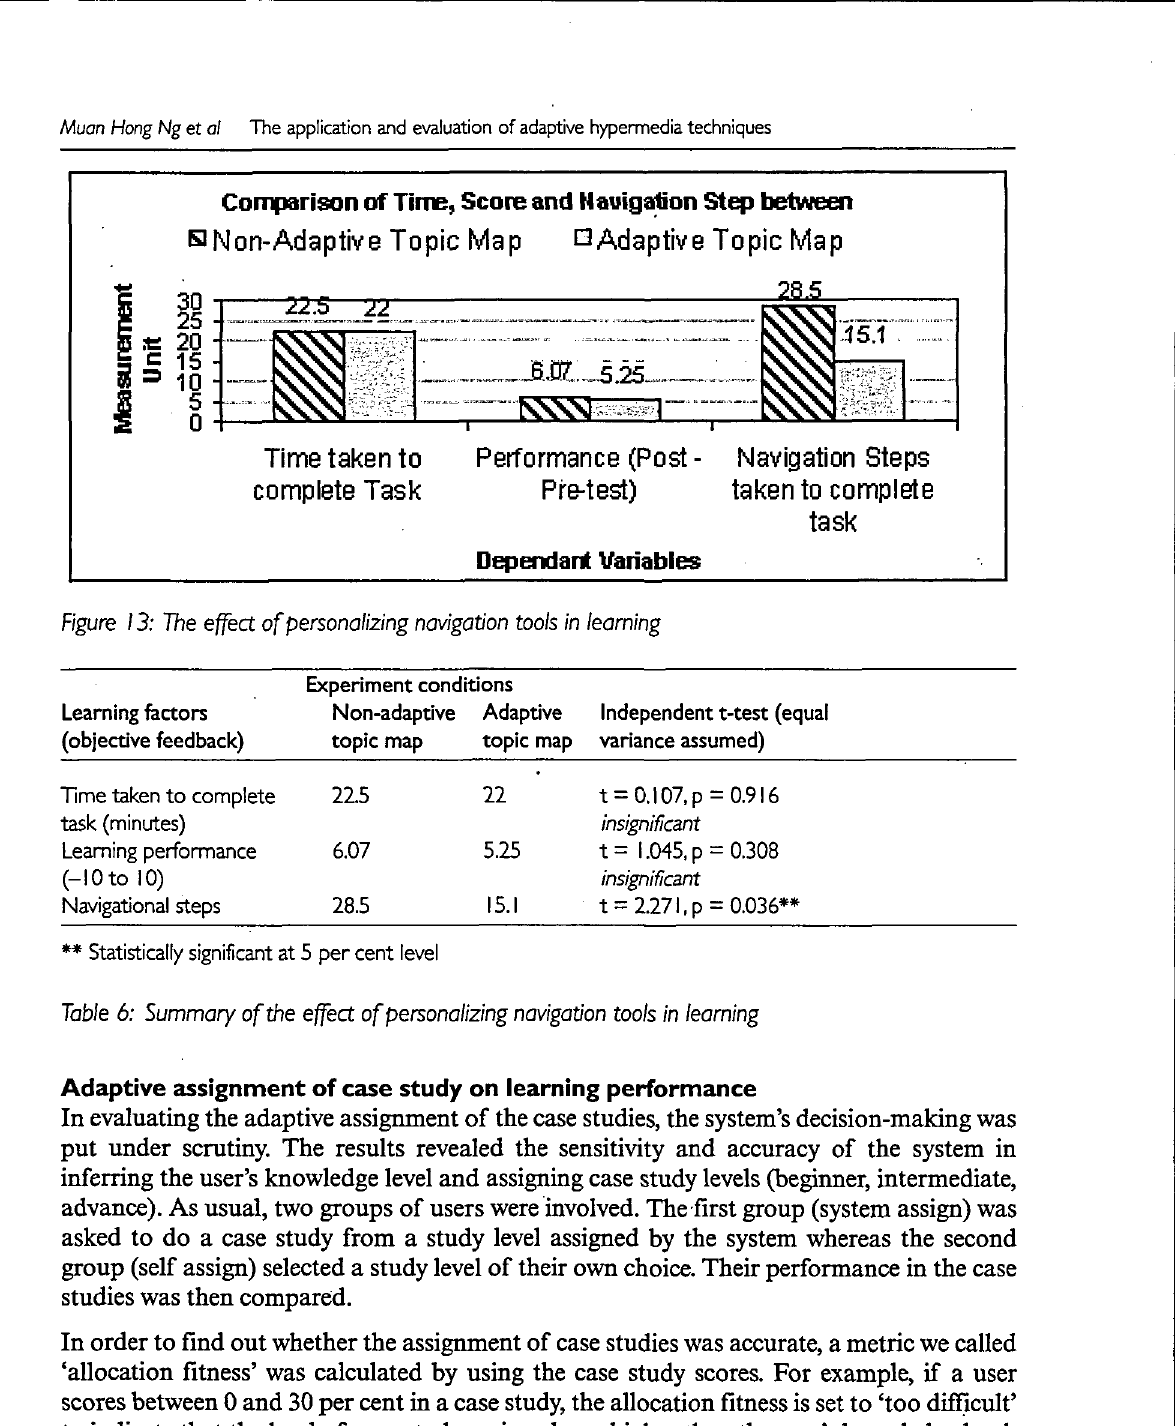
Table 6: Summary of the effect of personalizing navigation tools in learning Adaptive assignment of case study on learning